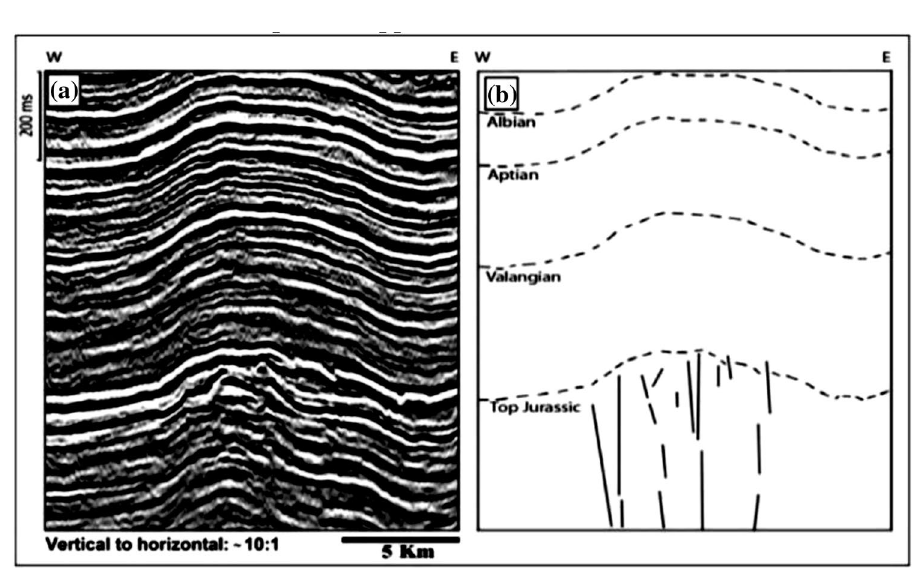
Fig. 17 Seismic profile across the Azadegan High, which shows a steep fault system in the Jurassic and underlying sedimentary rocks (Abdollahie Fard et al. 2006)